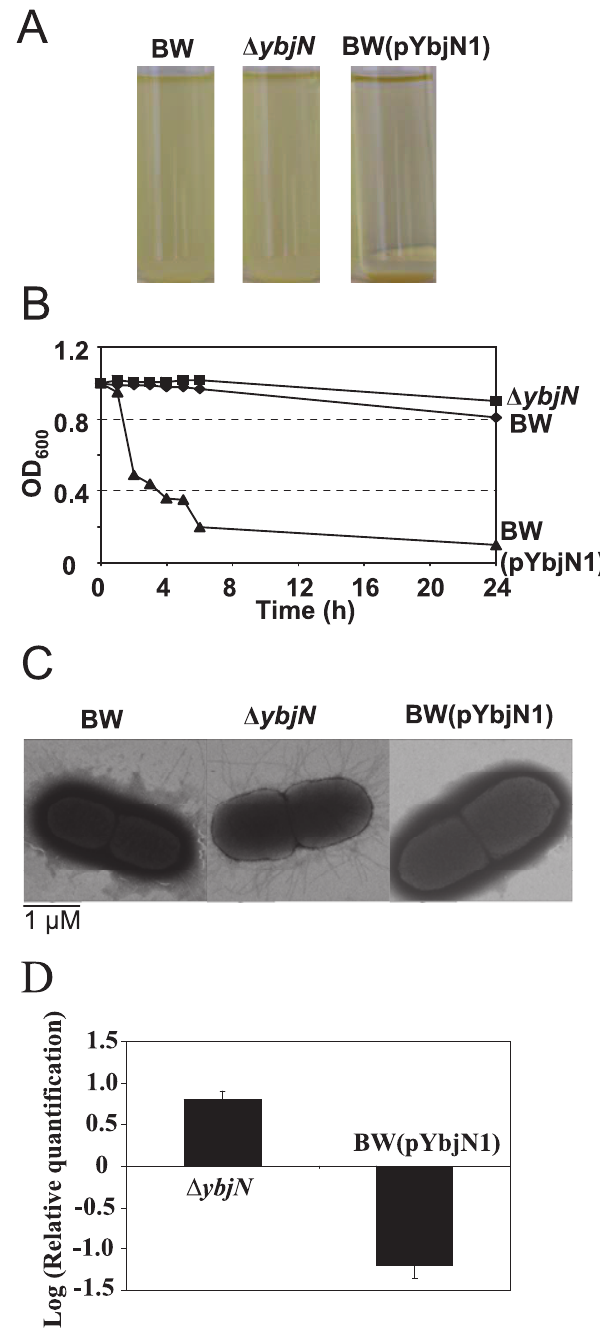
Figure 3. YbjN negatively regulates fimbriae formation and over-expression of ybjN results in autoaggregation. A. Demon- stration of quick autoaggregative phenotype conferred by ybjN overexpression. Cells were grown in LB broth overnight with shaking at 37 u C and allowed to settle for 6 h. BW: E. coli strain BW25113; BW(pYbjN1): E. coli strain BW25113 containing E. coli ybjN gene in pGEM T easy vector; B. Settling profile for E. coli strain BW25113, ybjN mutant and E. coli strain BW25113 over-expressing ybjN . Cells were grown in LB broth overnight at 37 u C with shaking. At the beginning of the experiment, all overnight cultures were mixed vigorously by vortexing for 10 s and OD 600 for each tube was measured. Tubes were then left at room temperature without interference and OD 600 for each tube was measured at the time points indicated. C. Transmission electron microscopy analysis of fimbriae formation for E. coli strain